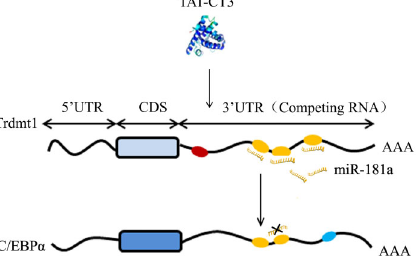
Figure 6. Illustration showing the mechanism of Trdmt on ceRNA. CDS: coding sequence; UTR: untranslated region; ceRNA: competing endogenous